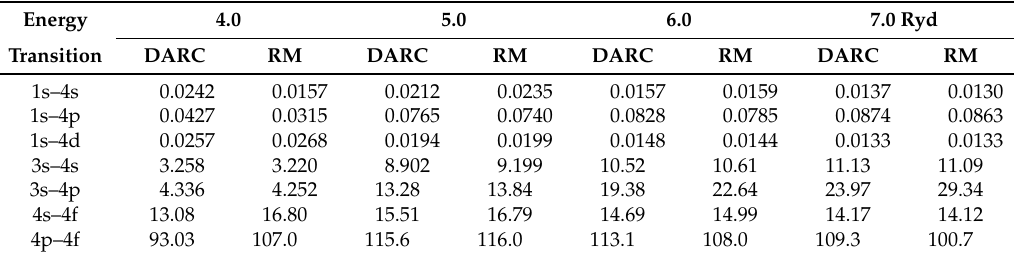
Table 5. Comparison of collision strengths ( Ω ) for some transitions of He II.